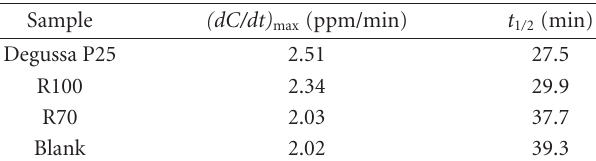
Table 2: Maximum degradation speed, (dC/dt) max , and semitrans- formation time, t 1 / 2 , calculated from the fitted curves reported in Figure